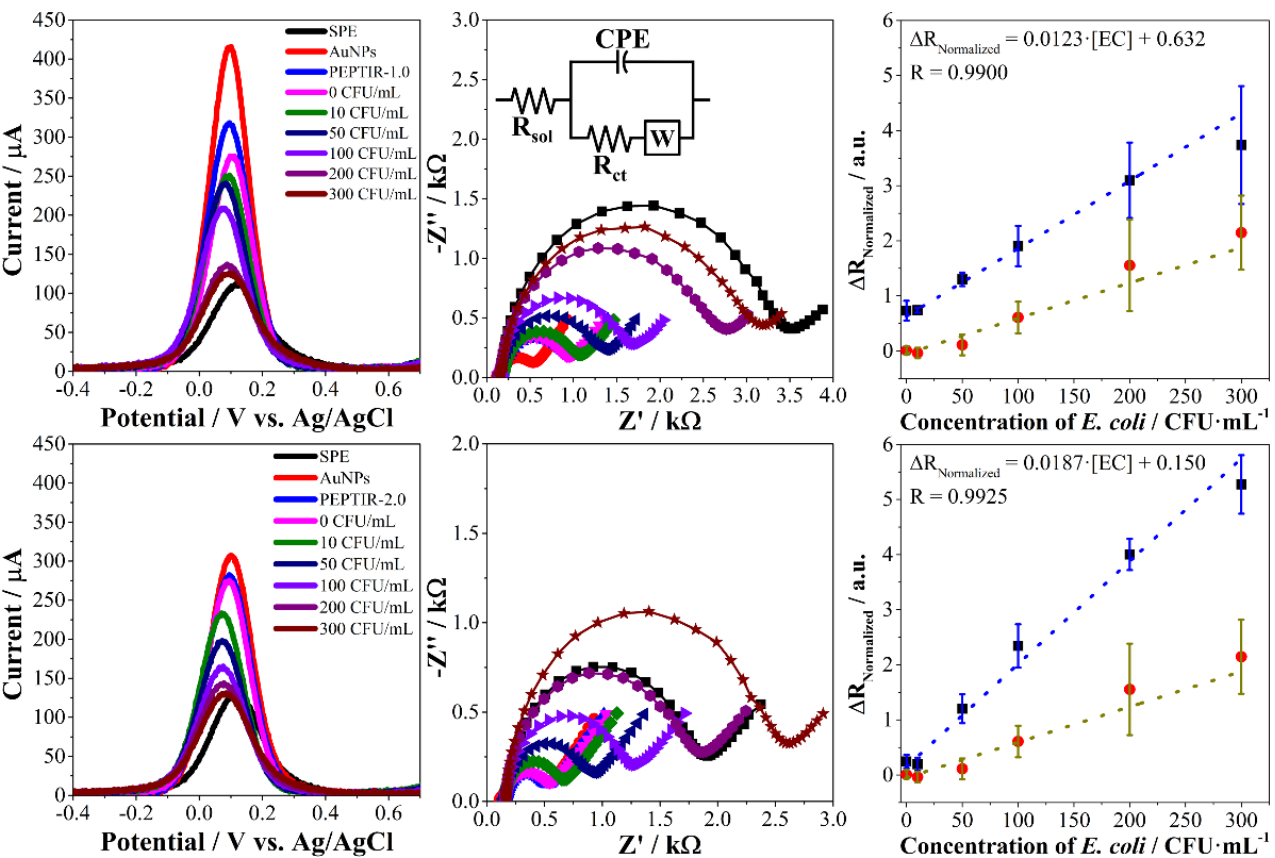
Figure 4. Square wave voltammograms ( left ), Nyquist plots ( center ), and calibration curves ( right ) of the biosensors prepared with 10 nM of PEPTIR-1.0 ( top ) and 5 nM of PEPTIR-2.0 ( bottom ) in the detection of E. coli O157:H7. The red points in the curves on the right correspond to the calibration curve of the biosensor blank (without using PEPTIR).